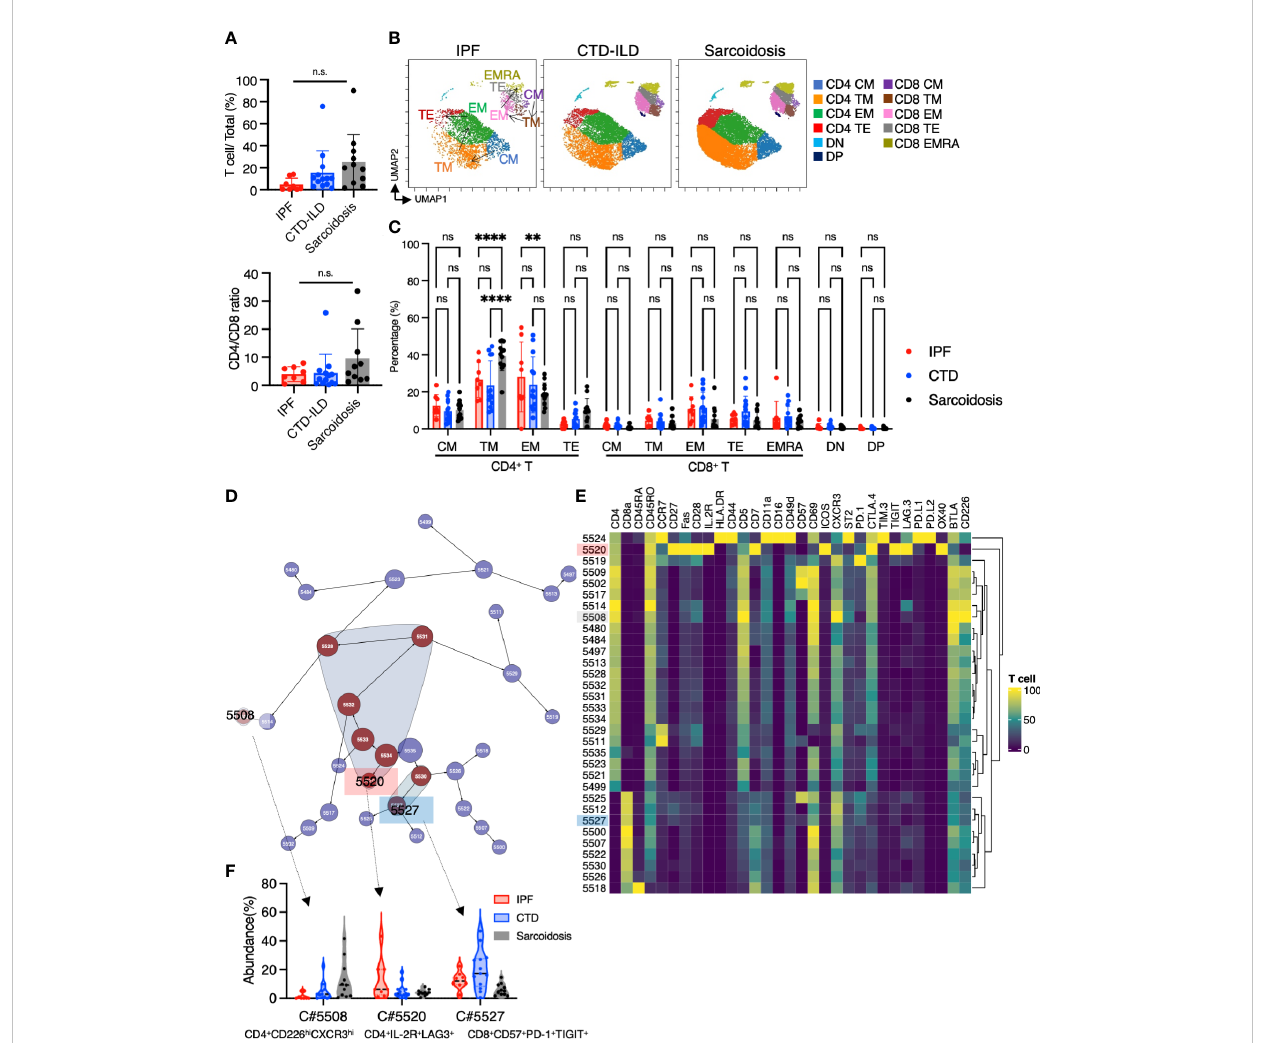
FIGURE 5 Characterization of T cell subsets in BALF from patients with IPF, CTD-ILD, and sarcoidosis. (A) The proportion of T cells (de fi ned by CD2 + CD3 + ) among CD45 + BALF cells and the CD4 + T cell/CD8 + T cell ratio from IPF (n = 8), CTD-ILD (n = 13), and sarcoidosis (n = 10). ns: not signi fi cant. (B) UMAP plots of concatenated samples visualizing the distribution of CD2 + CD3 + T cell differentiation in BALF from patients with IPF, CTD-ILD, and sarcoidosis. Central memory (CM) T cells are de fi ned by CCR7 + CD45RO + CD28 + Fas + , Transitional memory (TM) by CCR7 – CD45RO + CD28 + Fas + , Effector memory (EM) by CCR7 – CD45RO + CD28 – Fas + , Terminal effector (TE) by CCR7 – CD45RO +/ – Fas – , Effector memory RA (EMRA) by CCR7 – CD45RO – CD45RA + Fas +/ – . Arrows indicate the trajectory of T-cell differentiation. DN: CD4 – CD8 – double negative, DP: CD4 + CD8 + double positive. (C) Percentage of T cell subpopulations in IPF, CTD-ILD, and sarcoidosis. Graphical plots represent individual samples. Statistical differences were analyzed by two-way ANOVA followed by Tukey ’ s multiple comparison test. ns. not signi fi cant, ** p < 0.01, **** p < 0.0001. (D) The Citrus network tree displays the hierarchical relationship and intensity of each marker among the T-cell populations in BALF from IPF (n = 8), CTD-ILD (n = 13), and sarcoidosis (n = 10). (E) Heatmap illustrating the expression markers across different clusters of T cells as determined by the Citrus analysis. (F) Citrus-generated violin plots for three representative and differentially regulated populations. Each cluster number (C#) corresponds to the number shown in panel (D) . All differences in abundance are signi fi cant at a false discovery rate <